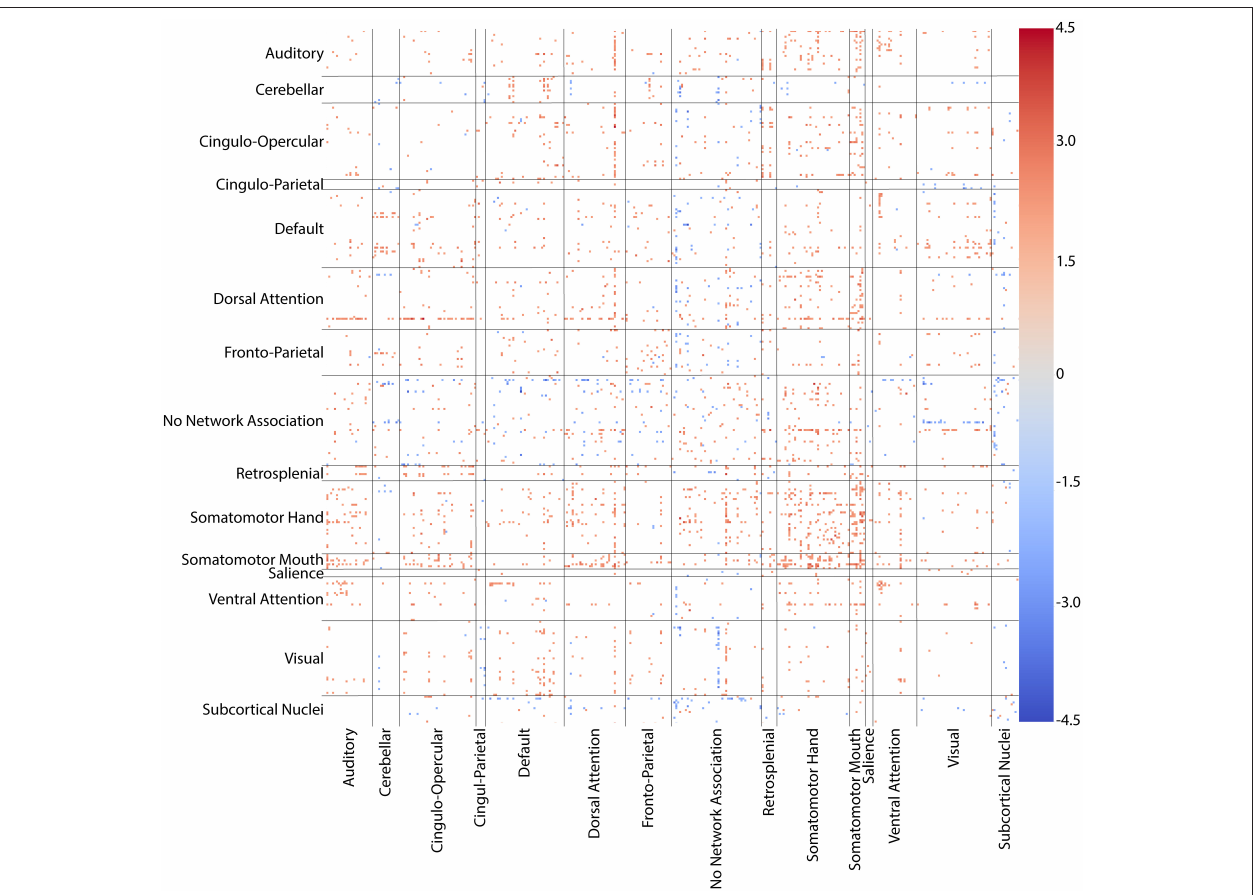
FIGURE 6 | Connectivity matrix of regions with altered connectivity between NP and control groups. T-statistic values for whole-brain, all-to-all comparisons between groups for the 361 ROI combined cortical, subcortical, and cerebellar parcellation. Somatomotor hand, somatomotor mouth, and dorsal attention networks showed widespread increases in connectivity with nearly every other network. Hyperconnectivity was particularly dense in somatomotor-somatomotor connections. Only connections with differences at p < 0.05 uncorrected are colored. Warm colors (reds) indicate an increase in connectivity in the NP group when compared to controls. Cool colors (blues) indicate a decrease in the NP